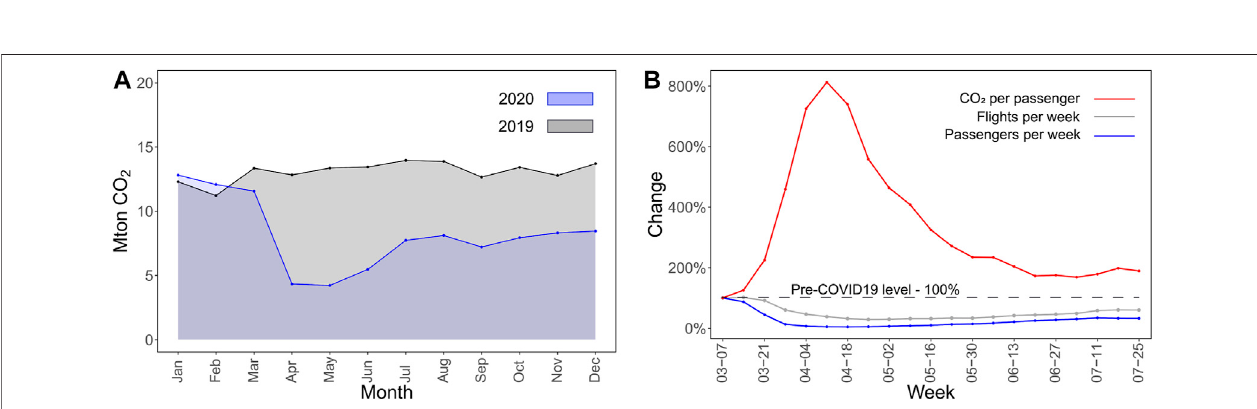
FIGURE 5 | United States air traf fi c CO 2 emissions produced during the pandemic. Domestic air traf fi c (A) , and Emissions per passenger (B) . Although total CO 2 emissions in 2020 dropped by 37.4% (58.6 Mton) compared to 2019, emissions per passenger have dramatically increased. The air traf fi c network remains robust because airlines continue fl ying aircraft with lower load factors. The cost of robustness is an increase in per-passenger emissions.